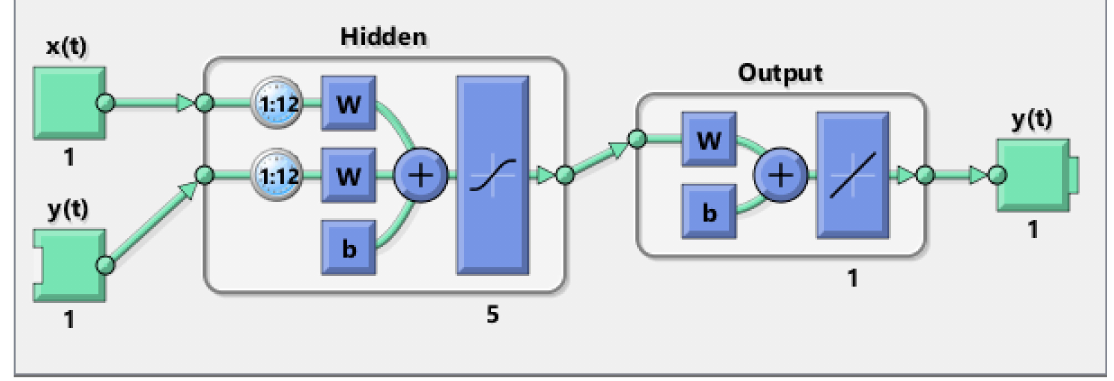
Figure 3. General architecture of a NARX model of neural networks (MATLAB,